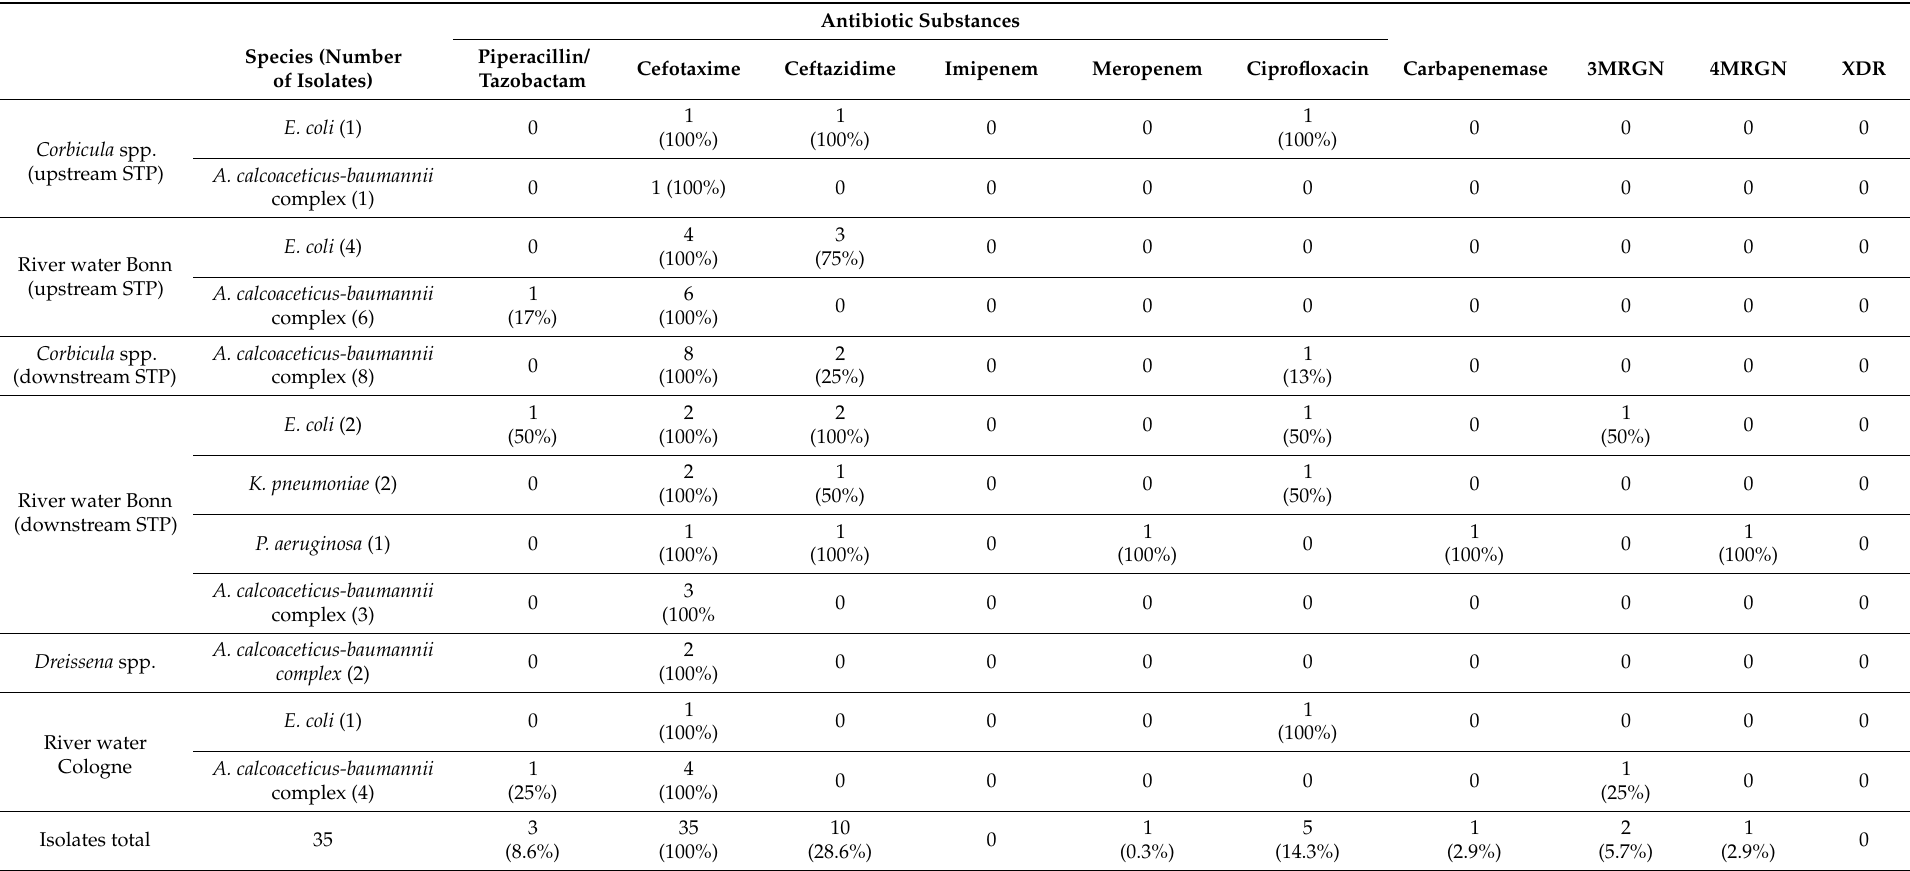
Table 2. Antibiotic-resistant isolates of the bacteria (isolated on the CHROMagar ESBL plates) from different sampling sites and matrices, detection of carbapenemase genes within the isolates and classification of German (3/4MRGN = multi-resistant Gram-negatives with resistance against three or four antibiotic groups tested) and international (XDR = extensively drug-resistant; showing resistance against all but one or two reserve antibiotic classes) multidrug resistance